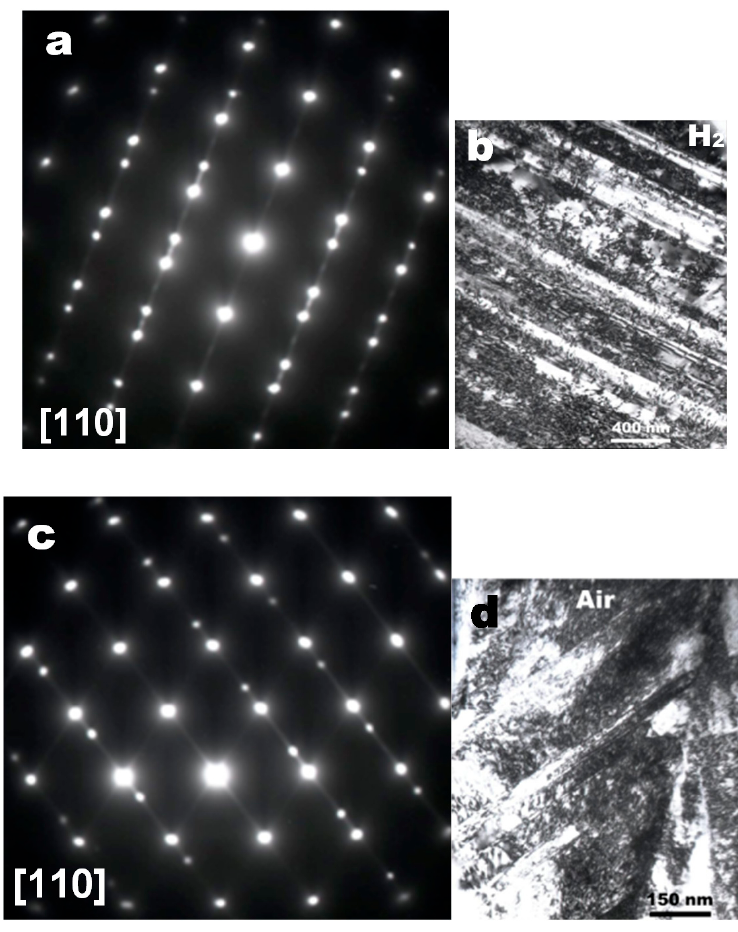
Figure 5. Twinning spots and streaks ( a , c ) observed when the planar dislocations ( b , d ) formed on the fracture surfaces of a 316 SS deformed in hydrogen ( a , b ) and air ( c , d ), respectively, were examined in the [110] zone axis. ( b , d ) added intentionally to show the twin streaks aligned perpendicular to planar dislocation boundaries (reproduced from [8] with permission from BH Choe, 2019).